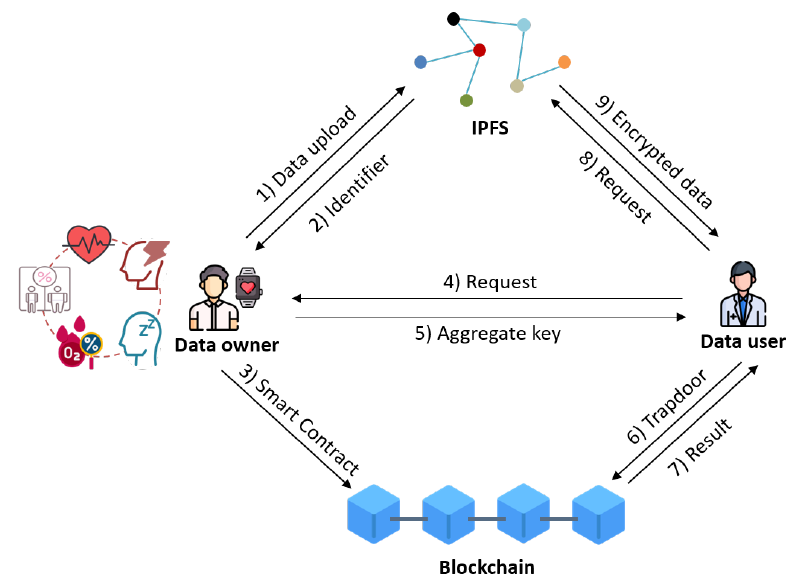
Figure 1. Network model of the proposed